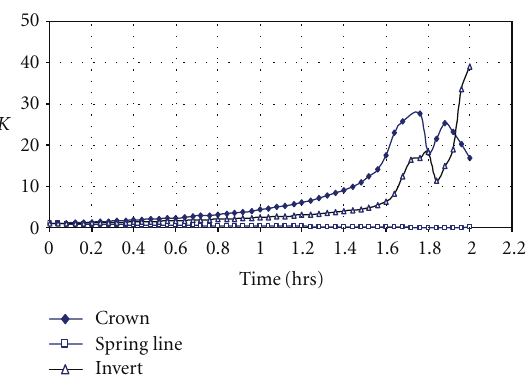
Figure 13: Variation of the overstress ratio (OSR) below the tunnel’s invert.